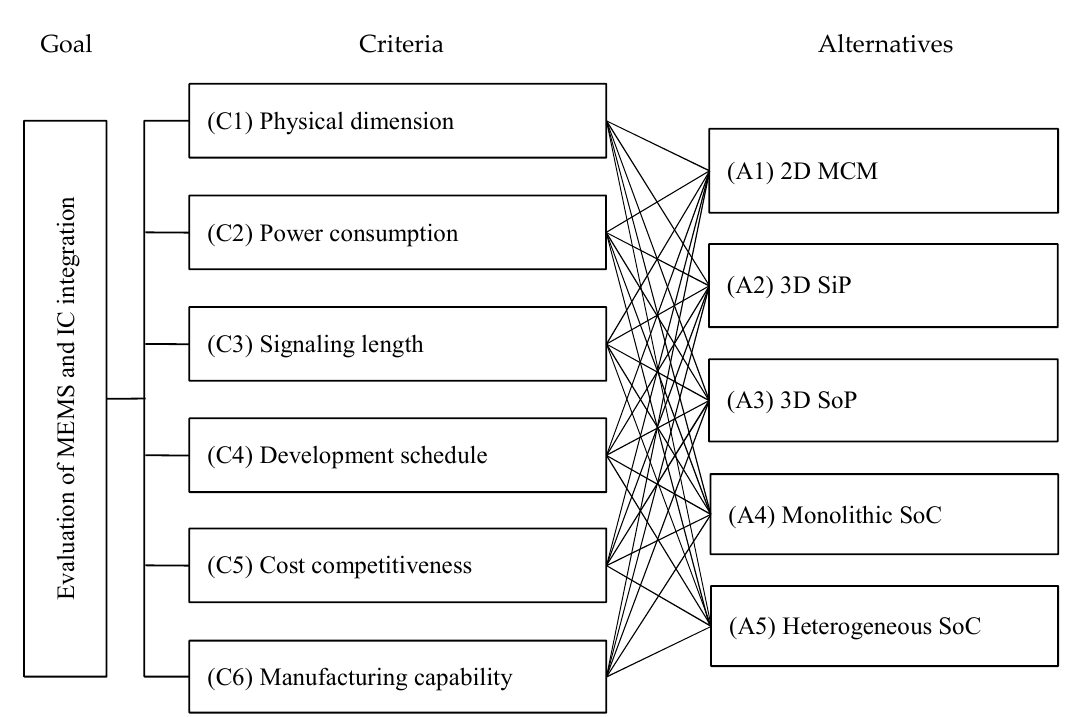
Figure 2. The hierarchical model for evaluating MEMS and IC (integrated circuit) integration technologies. MCM, multi-chip module; SiP, system-in-package; SoP, system-on-package; SoC, system-on-chip.